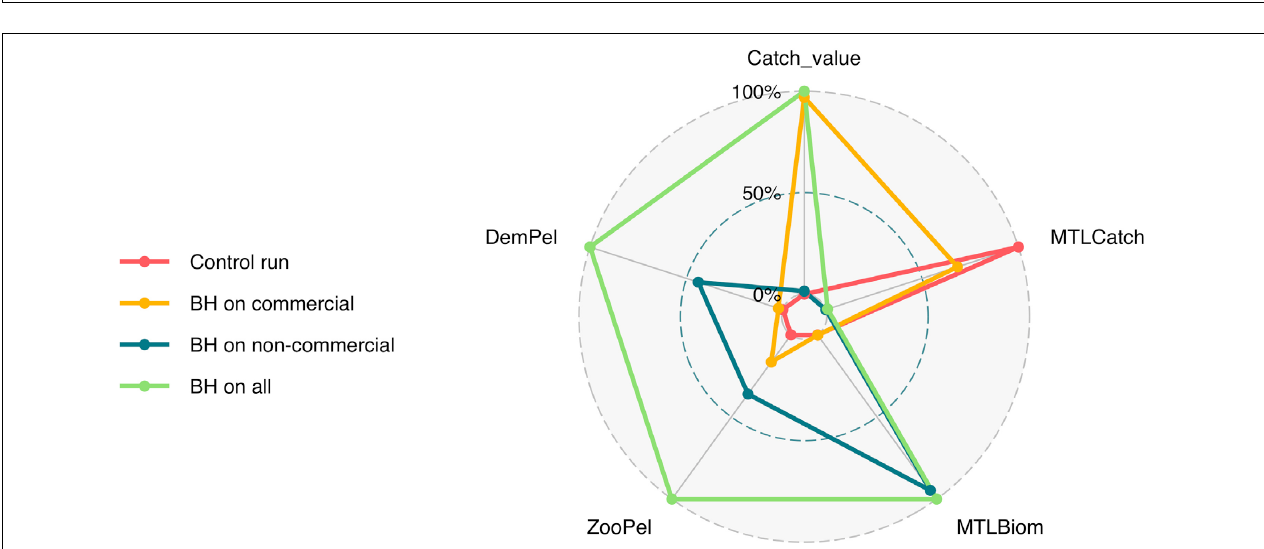
FIGURE 9 | The effects on the biomass where species are grouped as guilds. The plot shows the relative changes in biomass for the last 20 years of the simulations for three runs compared to the initial control run were traditional fisheries were applied. The colored bars cover the range of responses from minimum to maximum, the black circles are the mean response within a guild, while the triangles show the response of individual species or functional groups.